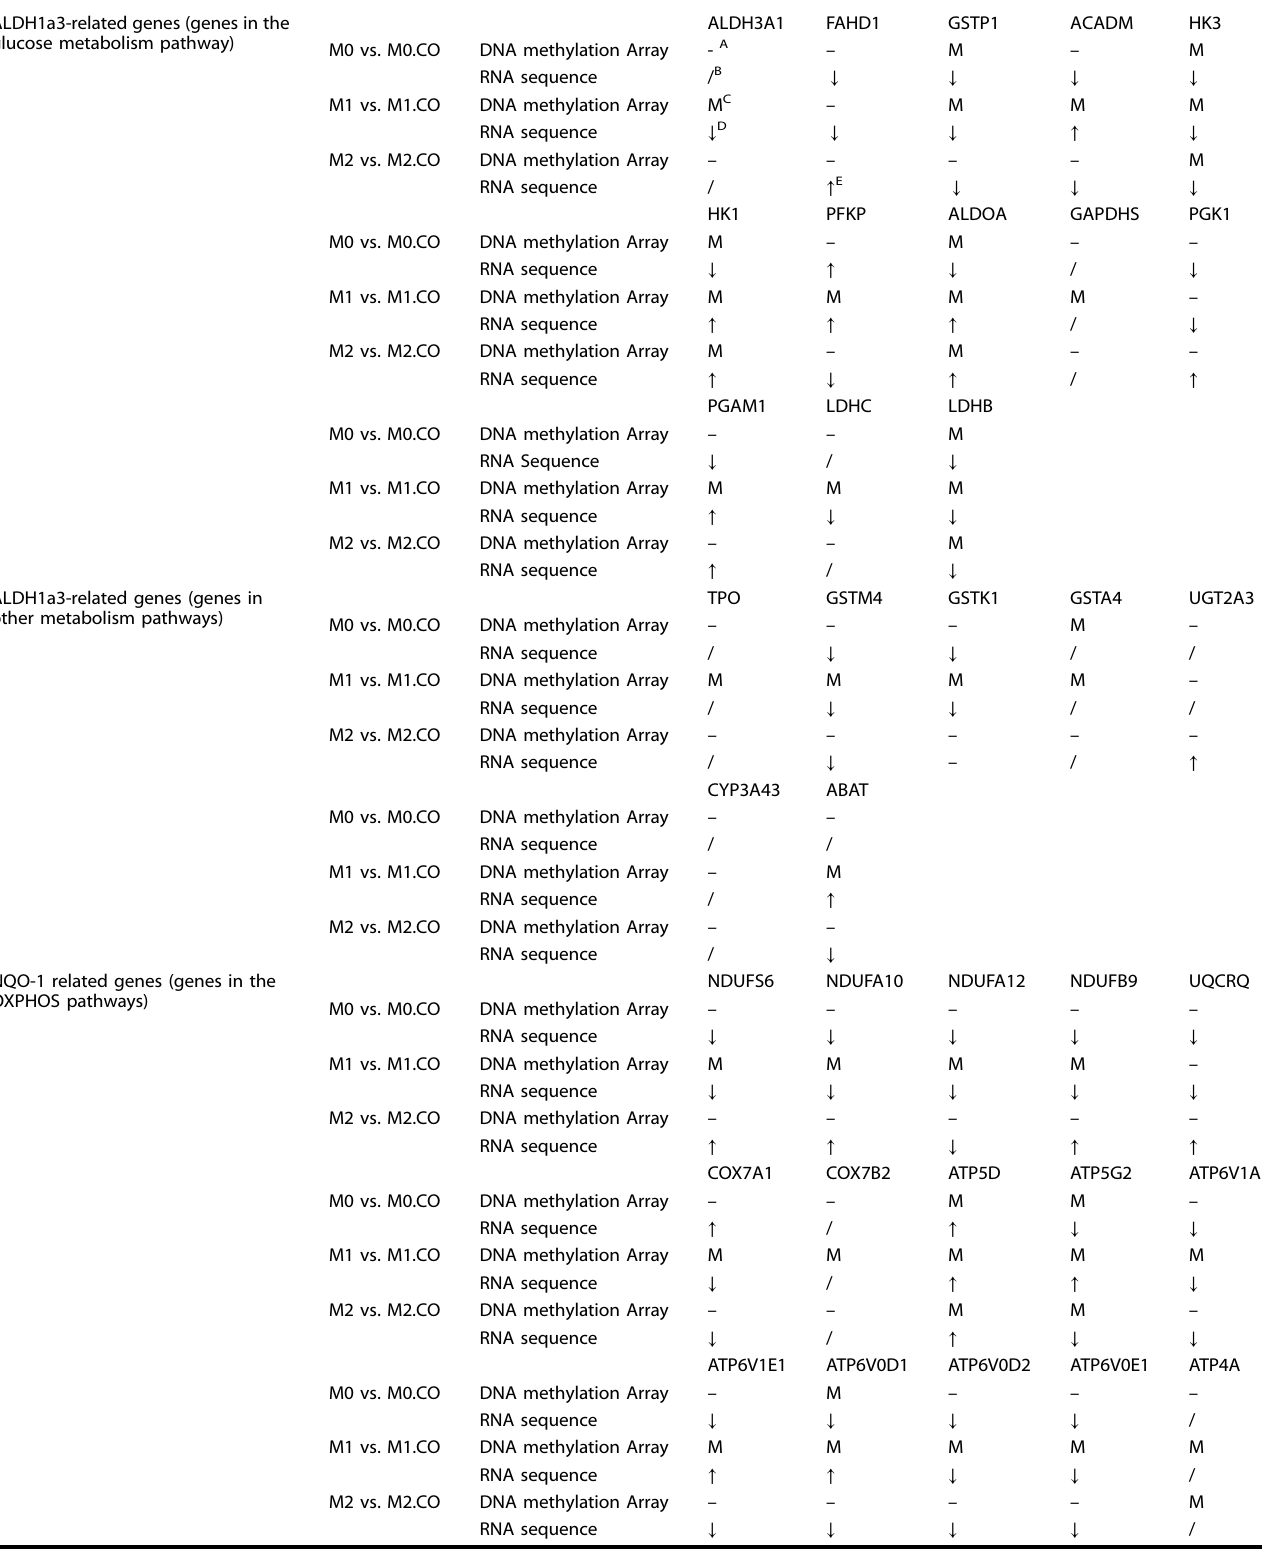
Table 1. Summary of the analysis of the 35 metabolism genes in human M0, M1-like, and M2-like macrophages upon interacting with PDA tumor cells ALDH1a3-related genes (genes in the glucose metabolism pathway)